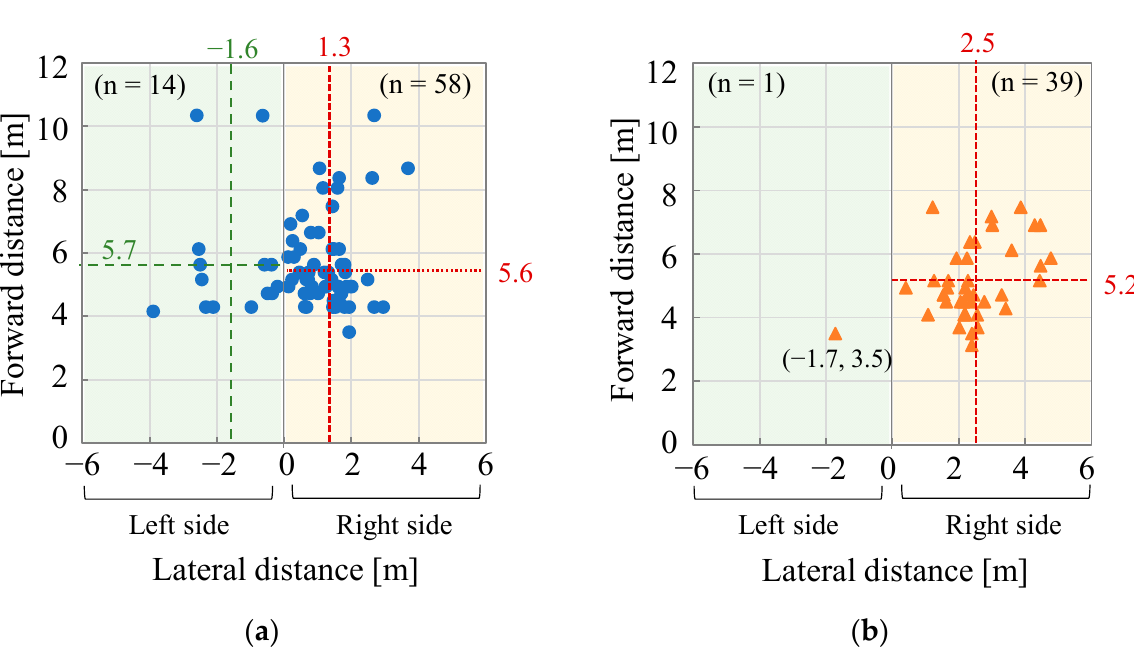
Figure 8. Positional distribution of ego vehicles and pedestrians when the drivers applied the brakes: ( a ) Left-Pedestrian ( n = 72); ( b ) Right-Pedestrian ( n = 40).